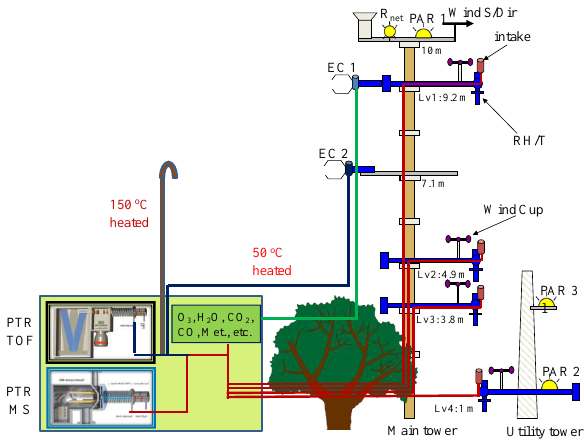
Fig. 1. Schematic diagram of PTR-TOF-MS and PTR-MS flux and vertical gradient measurement setup. The inlet at 7.1 m (EC 2) was shared by PTR-TOF-MS and PTR-MS for flux measurements during the first 30 min of each hour. Vertical gradients were measured with the PTR-MS for the second 30 minutes of each hour sequentially at four heights (Lv 1-4) while the PTR-TOF-MS sampled from the 150 o C heated inlet located at 7.1m.